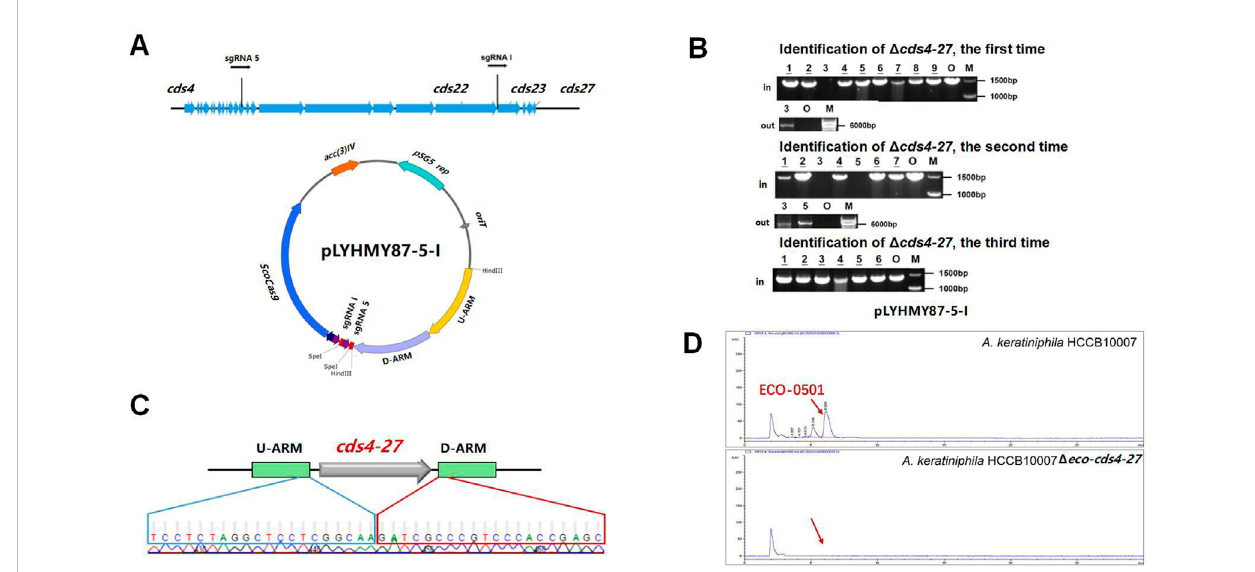
FIGURE 5 CRISPR/Cas9-mediated deletion of large fragment in ECO-0501 BGC with dual sgRNAs expression cassettes. (A) The location of sgRNA5 and sgRNAI on the ECO-0501 cluster and the diagram of editing plasmid PLYHMY87-5-I with dual sgRNAs expression cassette. (B) PCR analysis of randomly selected colonies transformed with pLYHMY87-5-I veri fi ed the deletions of cds4-27 . The amplicons of 1403 bp were the products of the original strain and 6777 bp amplicons represented cds4-27 deleted mutants. M, GeneRuler 1 kb DNA Ladder (Fermentas). O, original strain A. keratiniphila HCCB10007. Lanes 1 – 9, colonies transformed with pLYHMY87-5-I targeting CDS4-27. The underline below the number indicated that the gene of the colony had not been knocked out after the veri fi cation of Verify-87in-F/R. (C) Sanger sequencing results con fi rmed the correct deletion of the cds4-27 cluster. (D) HPLC detection of ECO-0501 of the secondary metabolites in the mutants indicated that there were no ECO-0501 production owing to the successful deletion of the cds4-27 cluster. The position indicated by the red arrow was ECO-0501